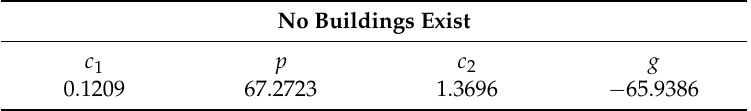
Table 8. The parameters of the gas diffusion model without the influence of